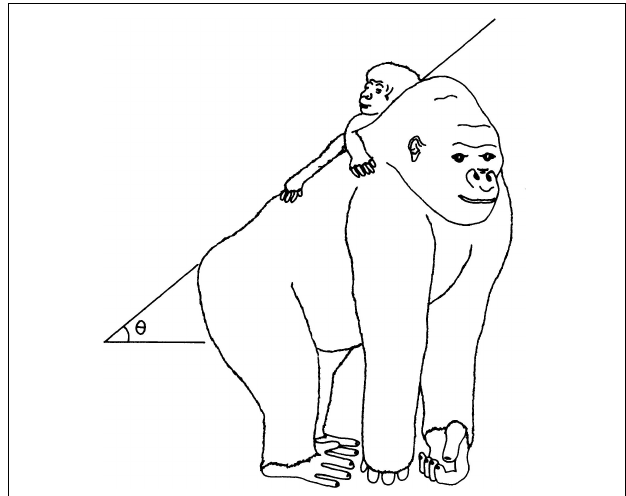
FIGURE 2 | Drawing (done by João Carlos Terassi) of the simplified mechanical problem, with an angle of inclination, discussed in the text and also in Amaral